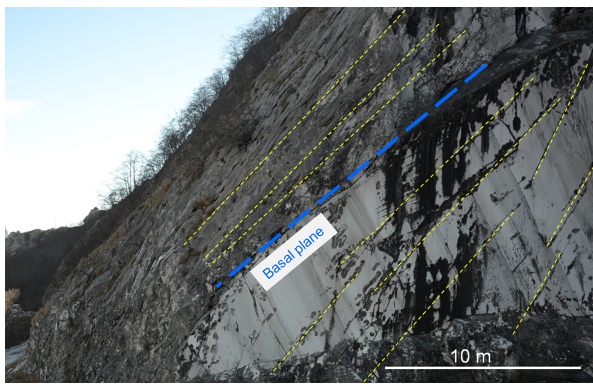
Figure 13. Details of a series of tight discontinuities above and be- low the basal plane under